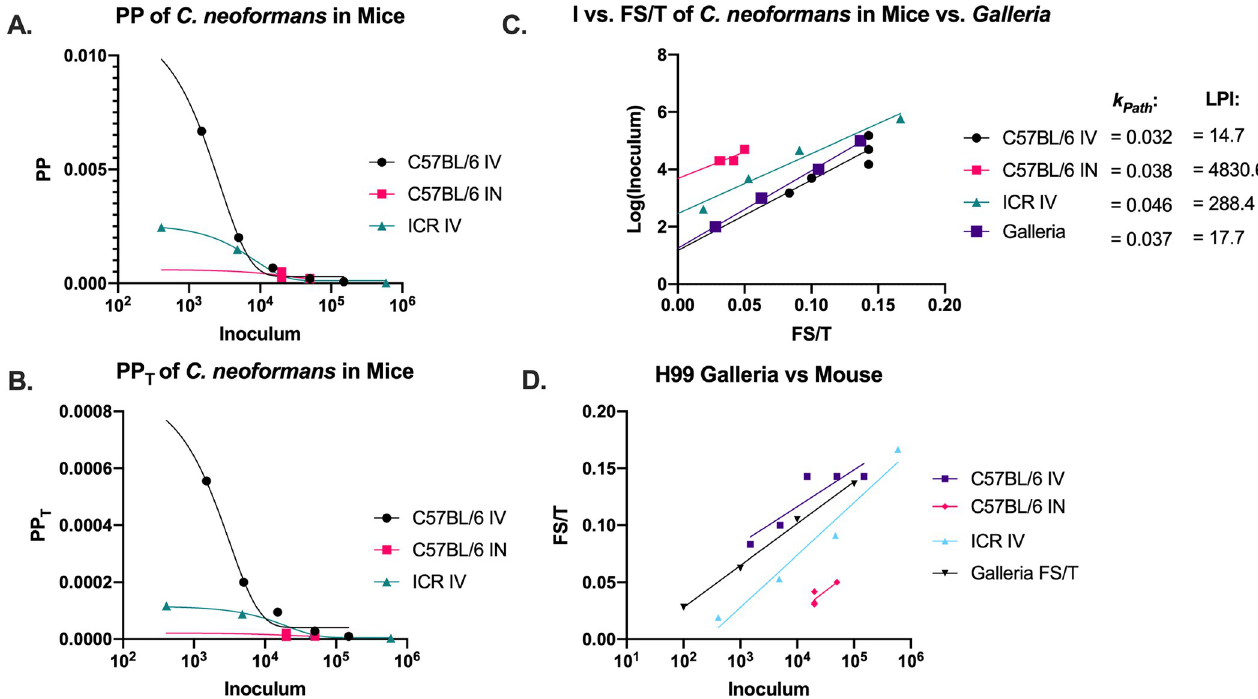
Fig 4. Pathogenic Potential of C. neoformans in mice . Using literature values [47–49] ,we calculated the (A) pathogenic potential (PP), (B) pathogenic for C . neoformans in mouse models through various potential in respect to time (PP T ), (C) Fs/T, (C) lowest pathogenic inoculum (LPI), and (C) k Path inoculation routes. Generally, the trends were consistent between the fungus in G . mellonella and murine hosts. (A) PP vs I and (B) PP T vs I data was fitted by a one phase exponential decay function, (C) log(I) vs. Fs/T was fitted by a linear regression, and (D) Fs/T vs I data was fitted by a semi-log line in which the x-axis is logarithmic. The (C) log(I) vs. Fs/T and (D) Fs/T vs I slopes were similar between the two hosts, indicating similar k Path